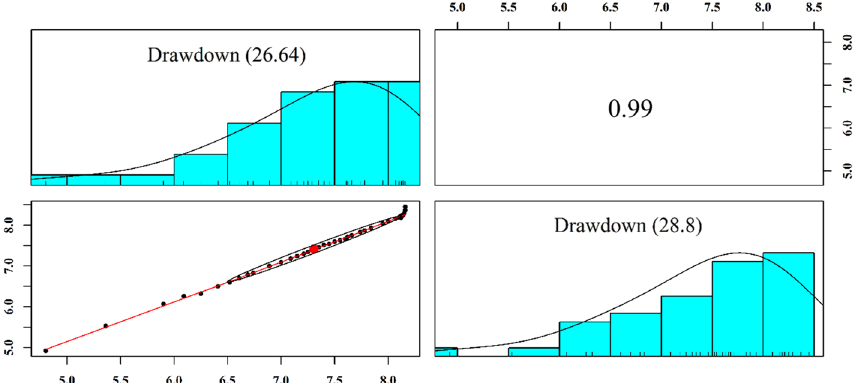
Fig. 10 Kendall’s tau results for the correlation between the val- ues of groundwater drawdown due to pumping with a constant discharge of 26.64 and 28.8 l/s